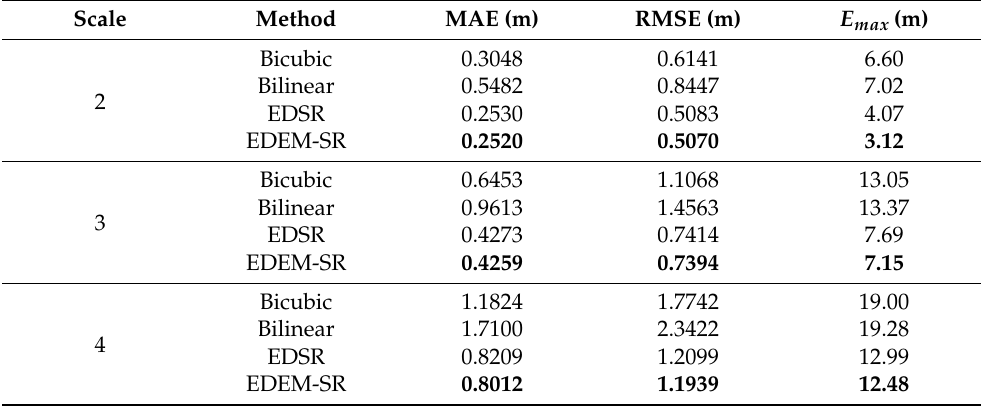
Table 2. Quantitative evaluation of the reconstruction effect of the test dataset.